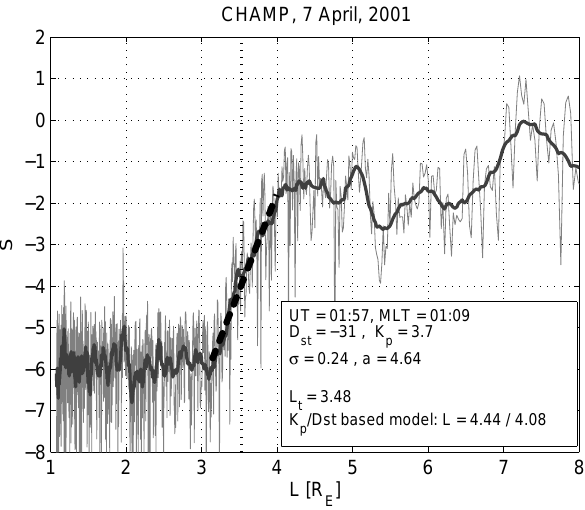
Fig. 3. Poorly definite transition of MSFAC